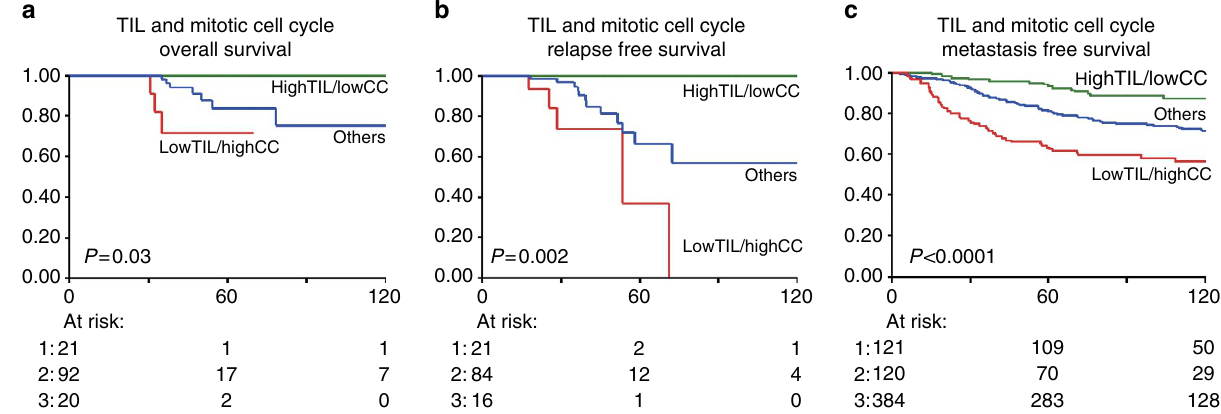
Figure 5 | Combined MCC and TIL-signature genes and outcome. Overall ( a ) and relapse-free ( b ) survival Kaplan (cid:3) Meier curves of our cohort and ( c ) metastasis-free survival of independent in-house and public data sets. Green line indicates patients with high expression of TIL genes (top quartile) and low expression of MCC genes (bottom three quartiles). The red line indicates patients with low expression of TIL genes and high expression of MCC genes. Blue indicates the remaining patients. P values are logrank-test for trend values. The x -axis shows time in months, y -axis shows the proportion of patients. For the numbers at risk, 1 indicates the highTIL/lowCC group (green line), 3 indicates the lowTIL/highCC (red line) and 2 the remaining patients.